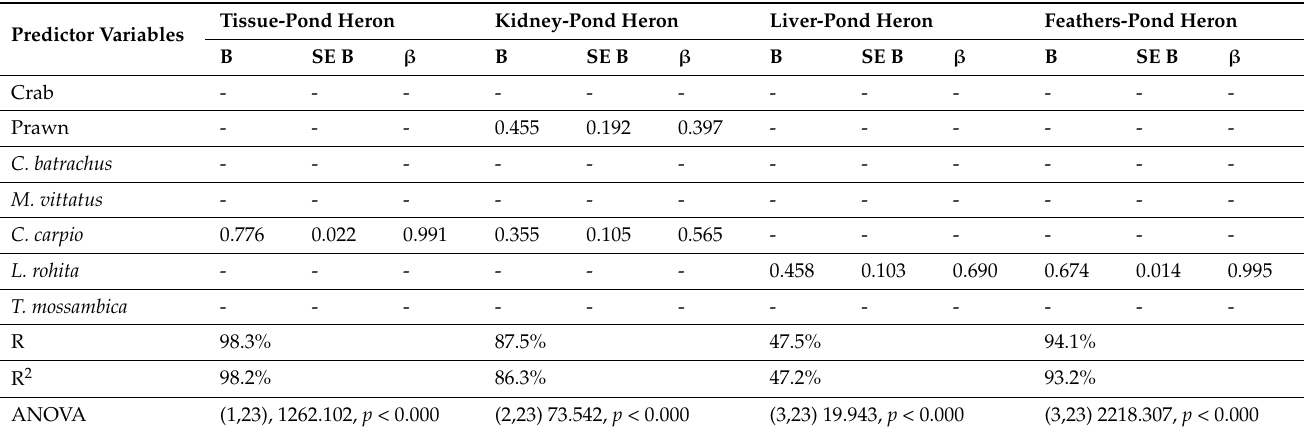
Table 6. A simple regression model explains the influence of various prey species on the accumulation of metals in tissues, kidneys, liver and feathers of Indian pond heron, Veeranam Lake, Tamilnadu, India.